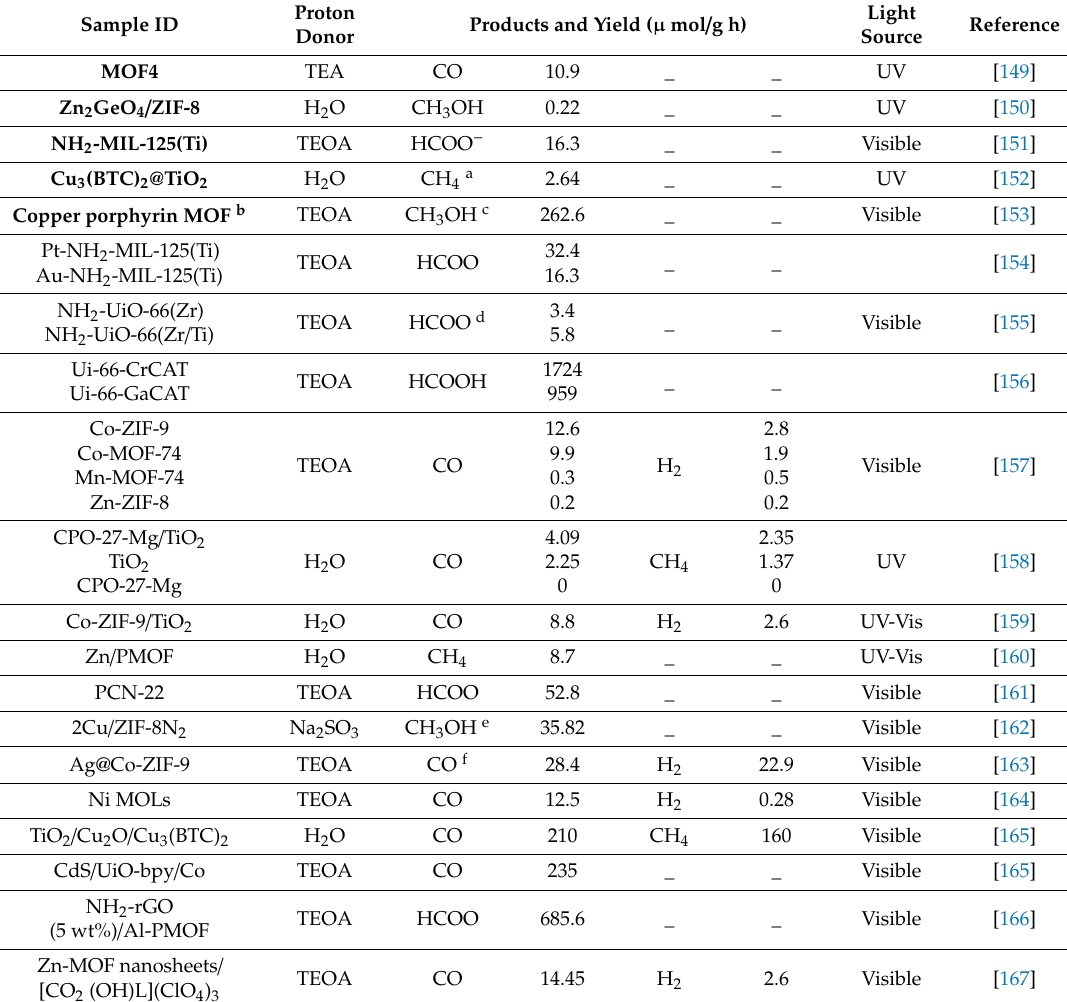
Table 8. Summary of MOF-based catalysts for photocatalytic CO 2